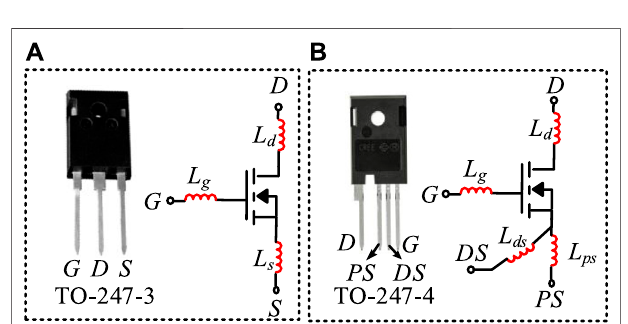
FIGURE 6 | (A) Package without Kelvin connection (B) with Kelvin